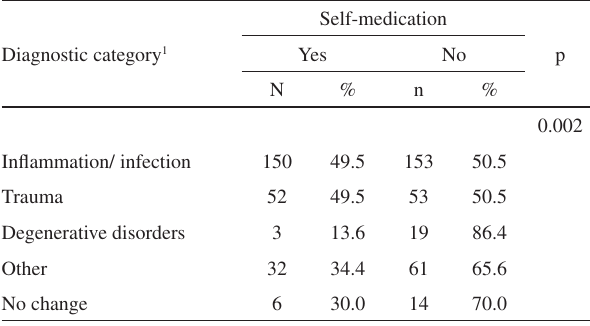
Table 5 - Use of self-medication to treat ocular conditions according to the diagnosis. (n = 543)